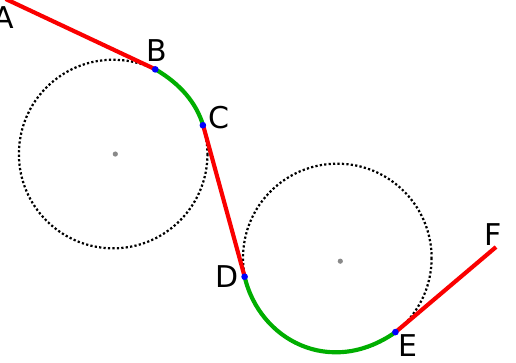
Figure 6. Path smoothing using Dubin’s curve. Straight segments AB, CD, and EF in red color are combined with circular arcs BC and DE shown in green